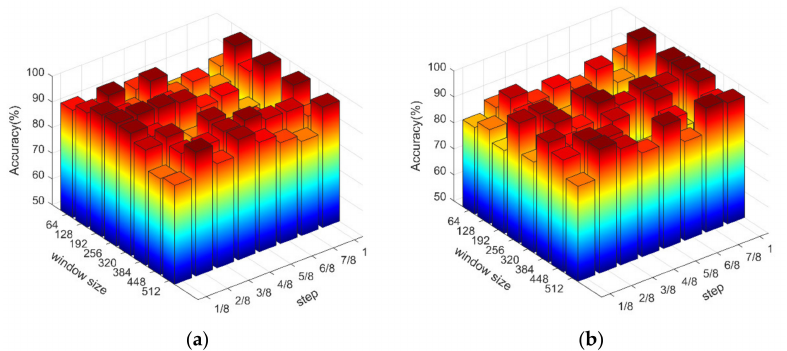
Figure 5. The results on Arousal ( a ) and Valence ( b ) for multiple window size and step